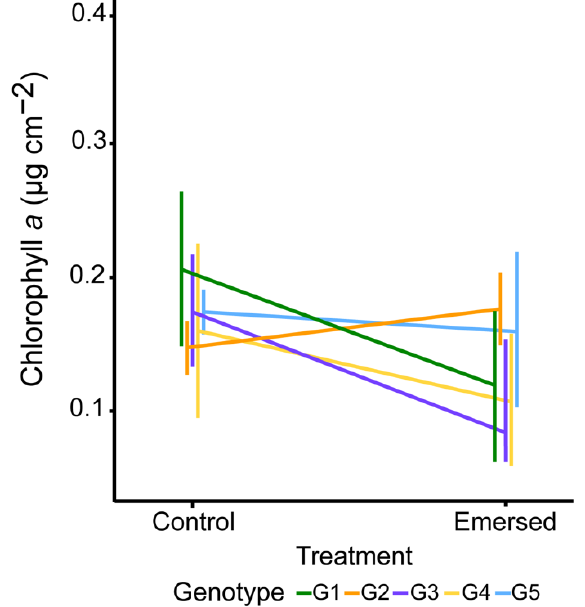
Figure 5. Reaction norms of all genotypes showing changes in chlorophyll a concentration following exposure to increased emersion duration.